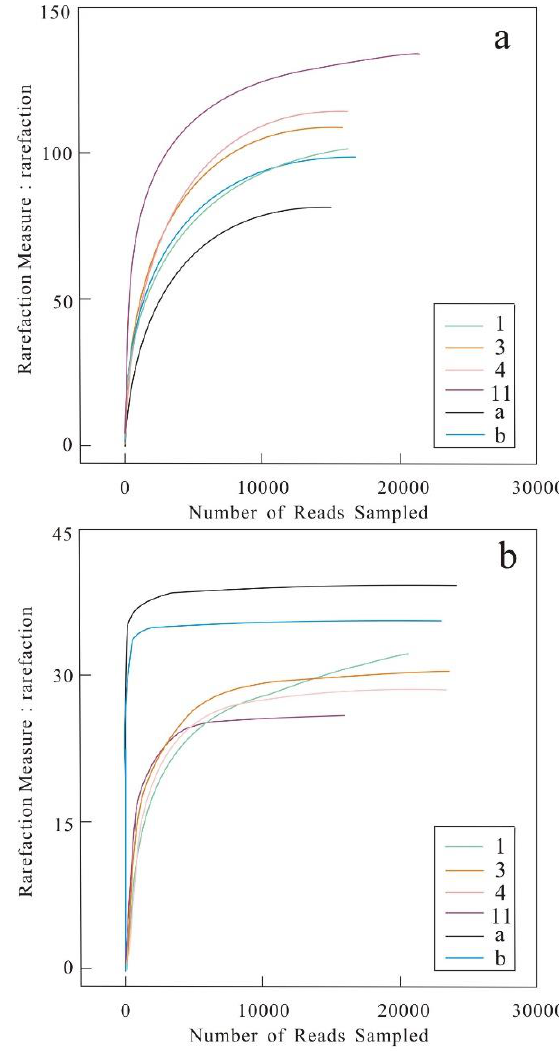
Figure 9. Rarefaction curve of bacteria ( a ) and archaea ( b ) from the samples across different wells.